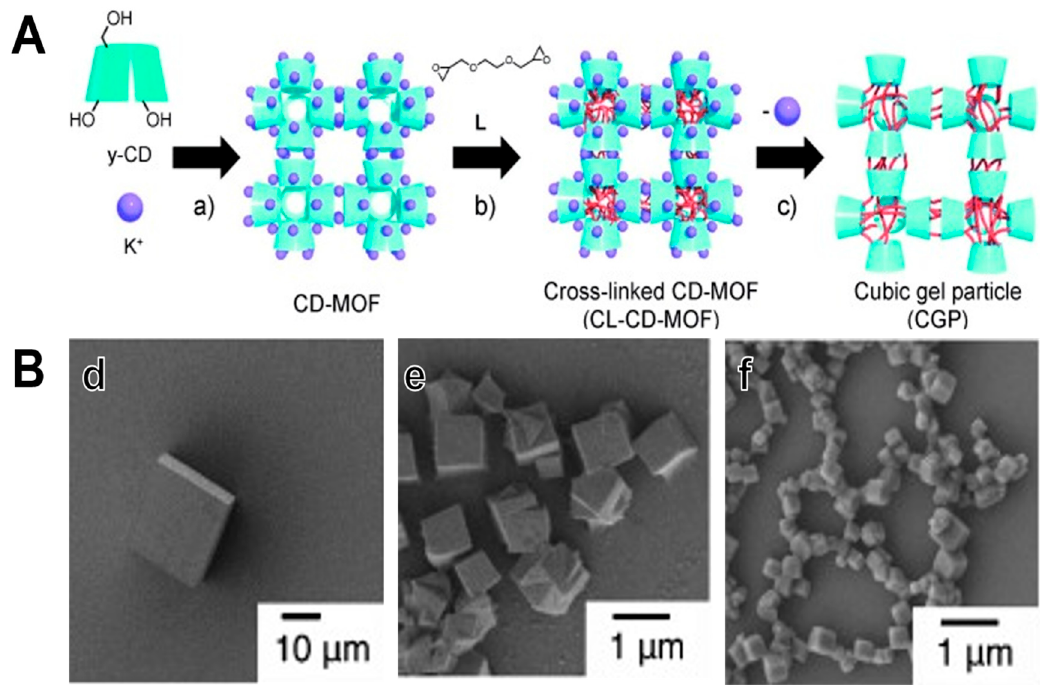
Figure 11. ( A ) Schematic illustrating the synthesis of cubic gel particles. ( a ) Crystallization, ( b ) Cross-linking reaction, and ( c ) Removal of coordinated metal ions. ( B ) SEM images of ( d ) CD ‐ MOF ‐ Micro1, ( e ) CD ‐ MOF ‐ Micro2, and ( f ) CD ‐ MOF ‐ Nano. Reproduced with permission from Ref. [149] Copyright 2012, John Wiley & sons.